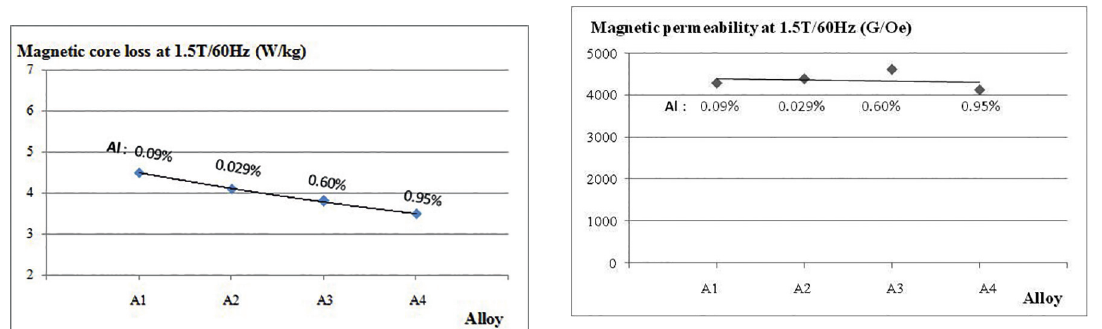
Figure 8: Variation of magnetic permeability in function of Al